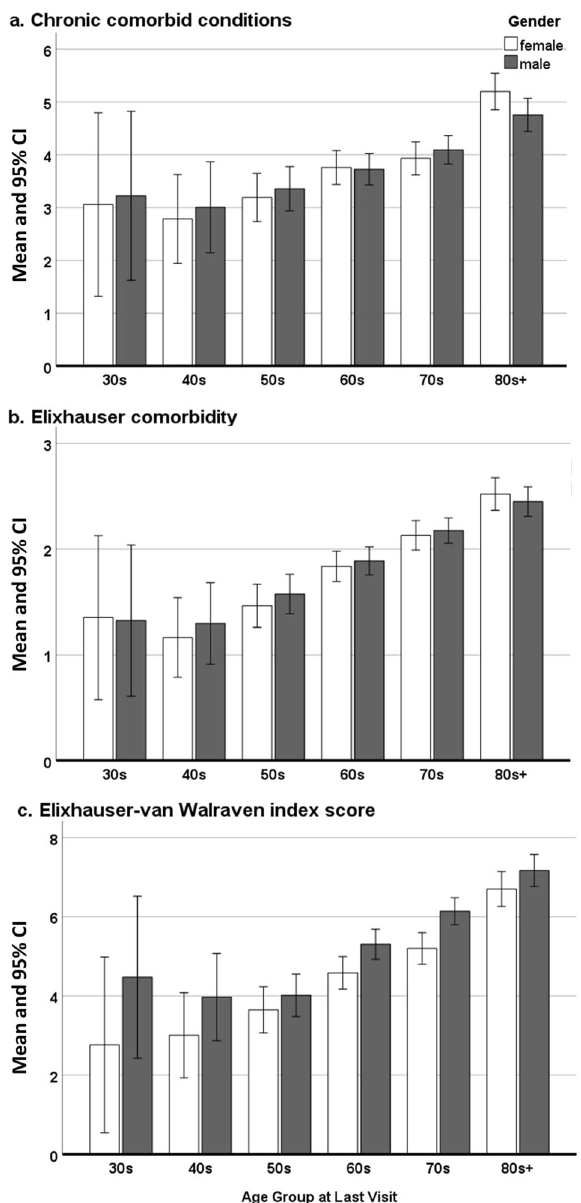
Fig. 1 Chronic comorbid conditions (CCC), Elixhauser, and Elixhauser-van Walraven index scores by gender and age group. Mean number of comorbidities with error bars representing 95% con fi dence